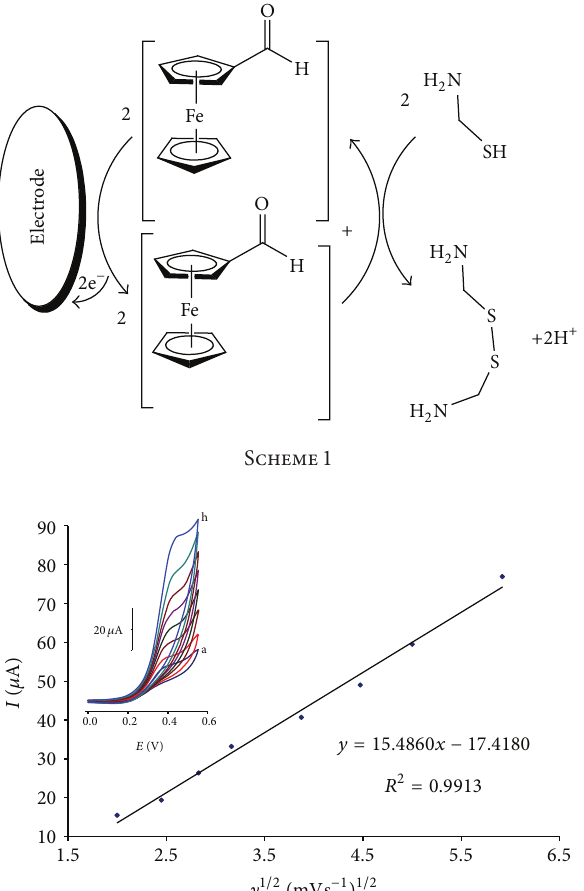
Figure 3: Plot of 𝐼 𝑝𝑎 versus ] 1/2 for the oxidation of cysteamine at FCAD/NiO/NPs/CPE. Inset: (A) cyclic voltammograms of 0.5 mM cysteamine at various scan rates: (a) 4; (b) 6; (c) 8; (d) 10; (e) 15; (f) 20; (g) 25, and (h) 35 mV s −1 in 0.1mol L −1 PBS (pH 7.0).